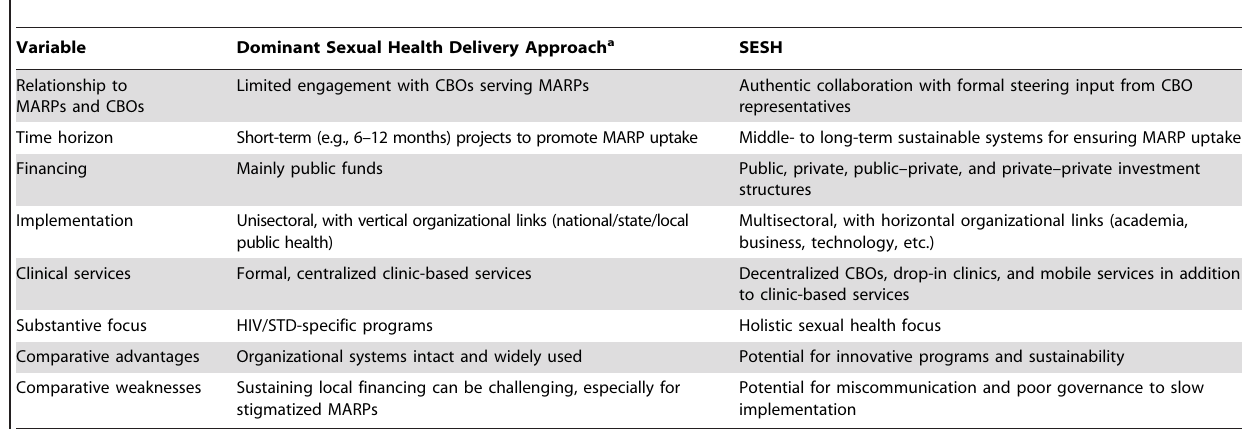
Table 1. Overview of the dominant current sexual health delivery system and the SESH delivery system.